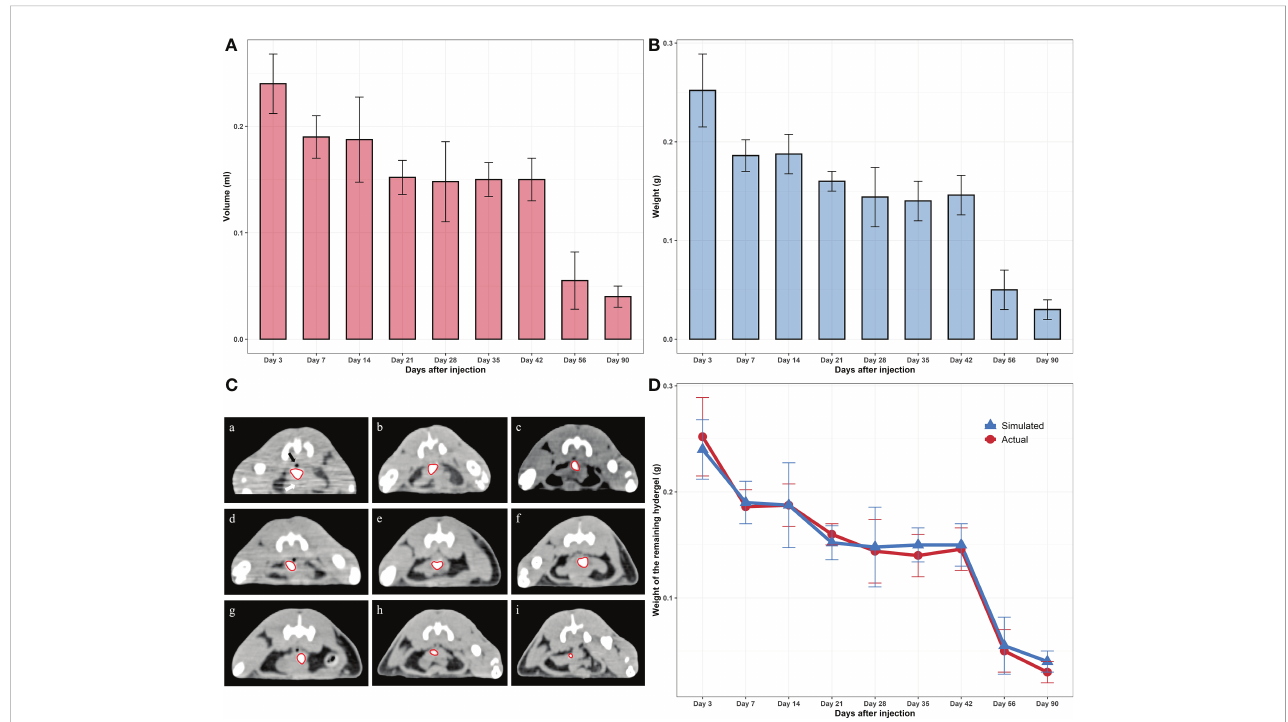
FIGURE 2 (A) Virtual (contoured) volumes of the residual hydrogels. (B) Weights of the actual residual hydrogels. (C) CT photos of the remaining hydrogels (scale bar = 3 cm); “ a ” to “ i ” represent 3, 7, 14, 21, 28, 35, 42, 56, 90 days after injection, respectively. (D) Comparison of the real and virtual weights of the